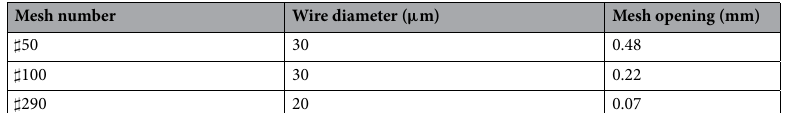
Table 1. Details of the samples used for co-deposition experiments: mesh number, wire diameter making up the mesh, and mesh opening.